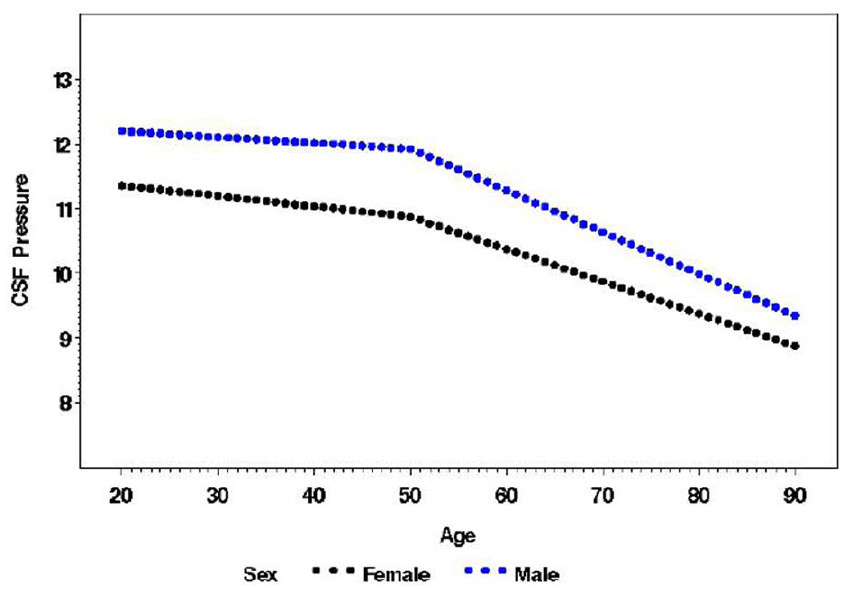
Figure 2. Segmented multivariate linear regression model CSFP (mm Hg) by age and sex. For each year of increase in age, CSFP decreased 0.009 mmHg (p=0.132) for age , 50 and by 0.056 mmHg, (p , 0.001) for age greater than 50. Prior to age 50, the slope is not different between males and females (p=0.369). After age 50, the gender difference in the slope is borderline significant (p=0.067). The r 2 of this model is 0.071.